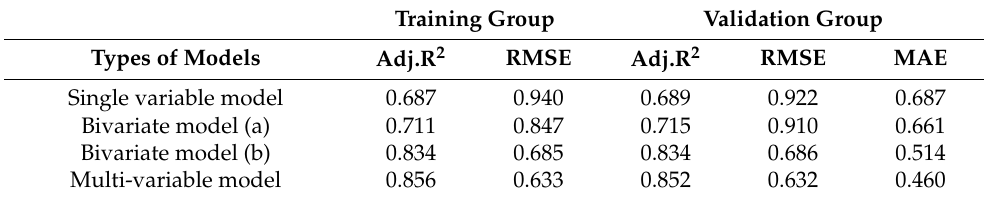
Table 5. The validation result (on a log scale) for models.